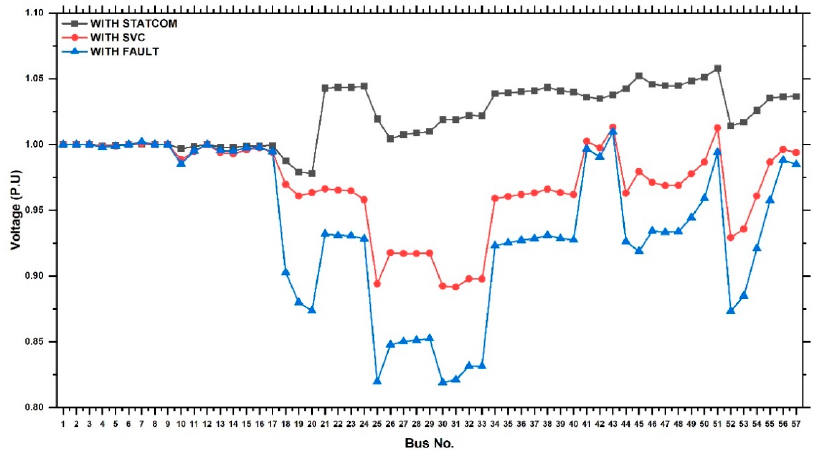
Figure 21. Comparison of a SVC and a